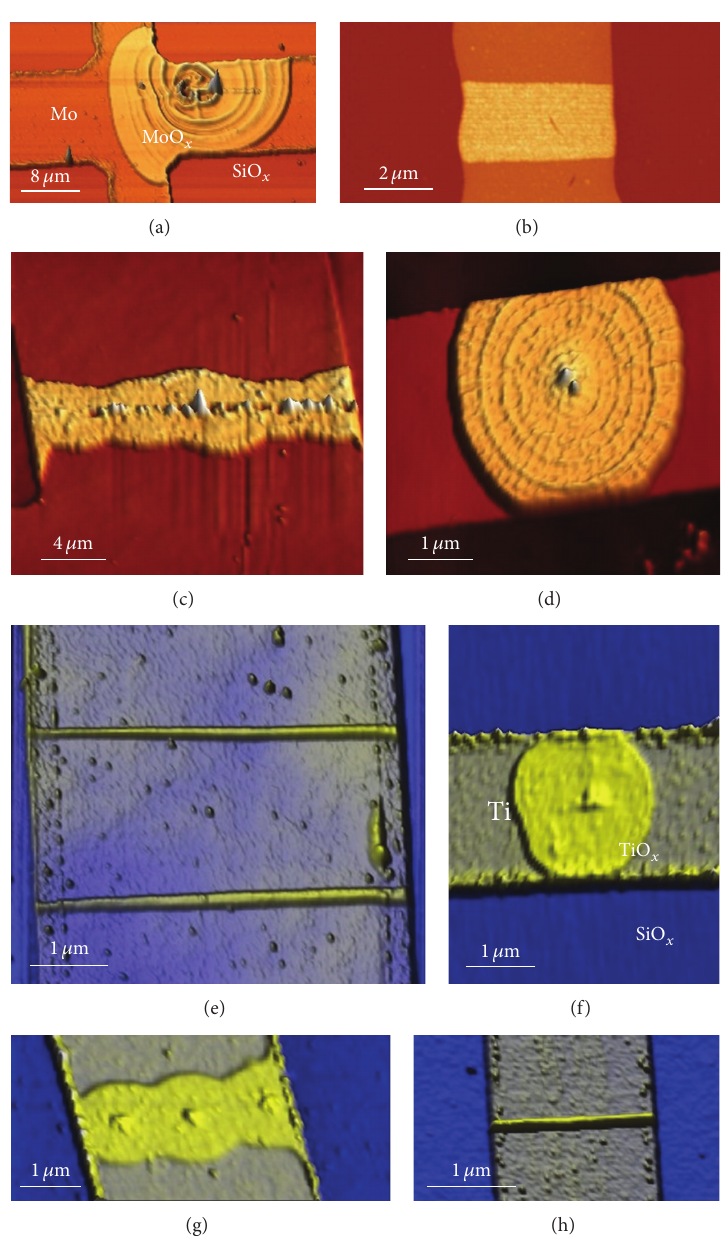
Figure 1: (Color online) Topographic AFM images of different nanosensors and microsensors fabricated via LAO routes. (a) A rounded- shaped Mo oxide region (light brown) is formed in the Mo track. (b) Image showing several consecutive oxide lines forming a micron-sized active region of the Mo oxide sensor. (c) Micron-sized single line sensor active region of Mo oxide. (d) A microsensor rounded-shaped Mo oxide region is formed in the center of the Mo track. (e) Image showing two consecutive active regions of a Ti oxide (yellow) nanosensor separated by several hundreds of nanometers. (f) Microsensor Ti oxide produced with the AFM tip at rest. (g) Image of a Ti oxide microsensor fabricated via three consecutive oxidation spots. (h) Nanowire-type Ti oxide region is formed in a Ti